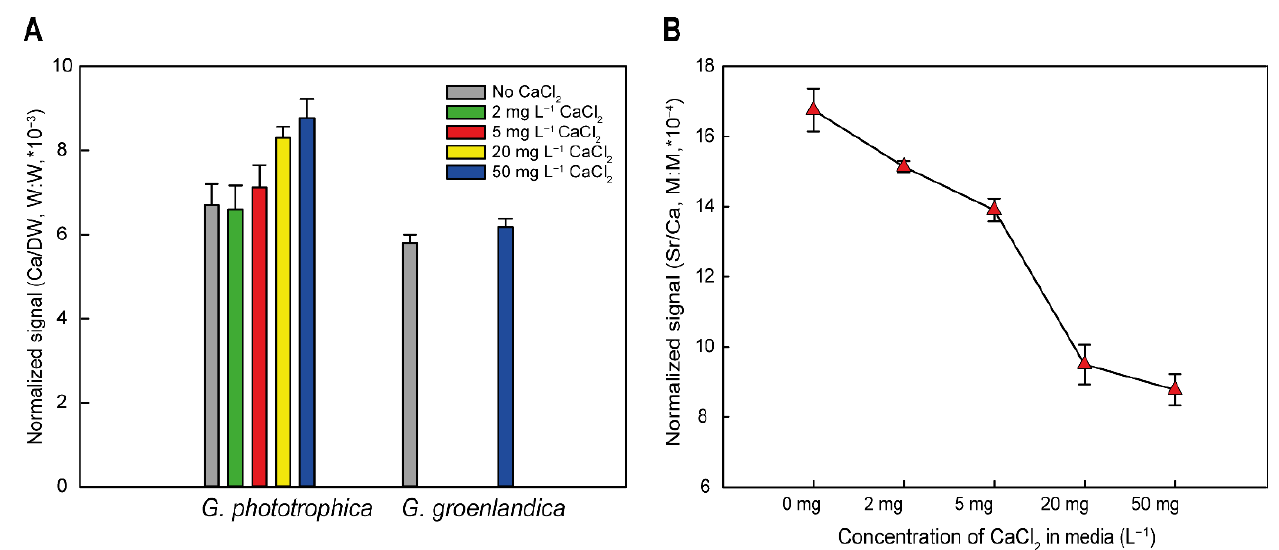
Figure 5. ( A ) Accumulation of calcium in G. phototrophica and G. groenlandica cells grown in nutrient media containing different concentrations of CaCl 2 . ( B ) Accumulation of strontium in G. phototrophica cells grown in nutrient media containing different concentrations of CaCl 2 .